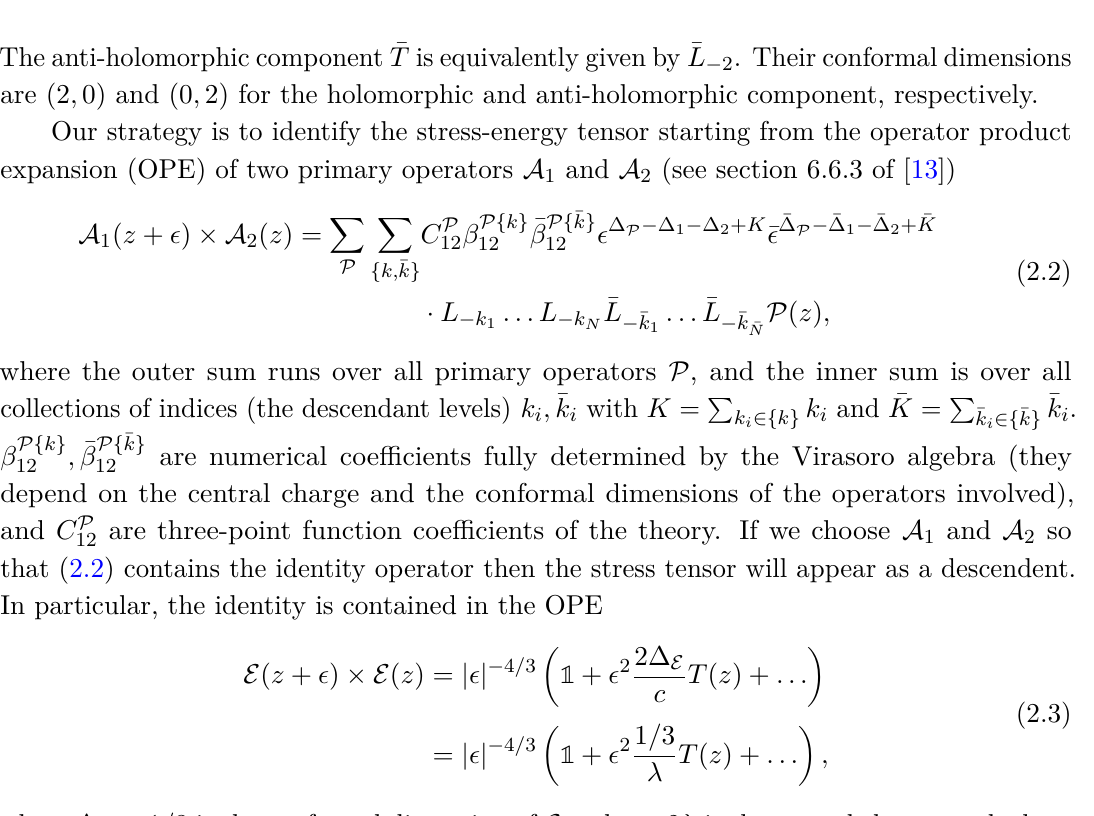
Figure 1 . The non-zero three-point function coefficients are shown. Rows and columns label ( p, p 0 ) for primary operators with dimensions ( p/ 3 , p 0 / 3) . Left: between two edge-counting operators. Right: between two vertex operators. The operators giving contributions to T , corresponding to 1 (left) and 1 , J, W (right) are marked in red